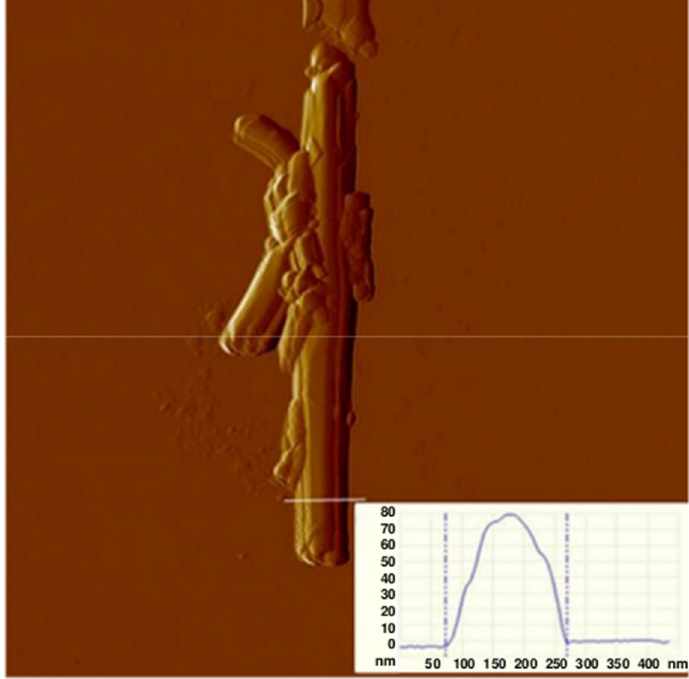
Figure 3. Scanning force microscopy (SFM) “tapping amplitude” image of a single HNT and corresponding section analysis (inset). (image size: 2.5 μ m)